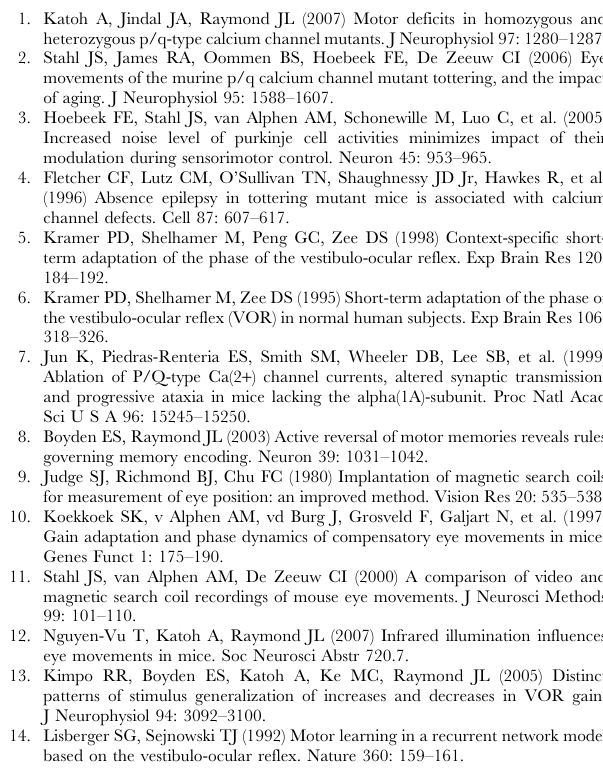
Figure S2 Average changes in A) VOR gain and B) VOR phase induced by each visual-vestibular training paradigm in experi- mentally naı¨ve animals; wild-type mice on the abscissa and the P/ Q mutants on the ordinate, as in Fig. 2. The training paradigm is indicated by the letter below each set of corresponding data points (a–j, see Table 1). Error bars indicate standard error. No data are available for x1.4/90 u lead training in tgla / + .